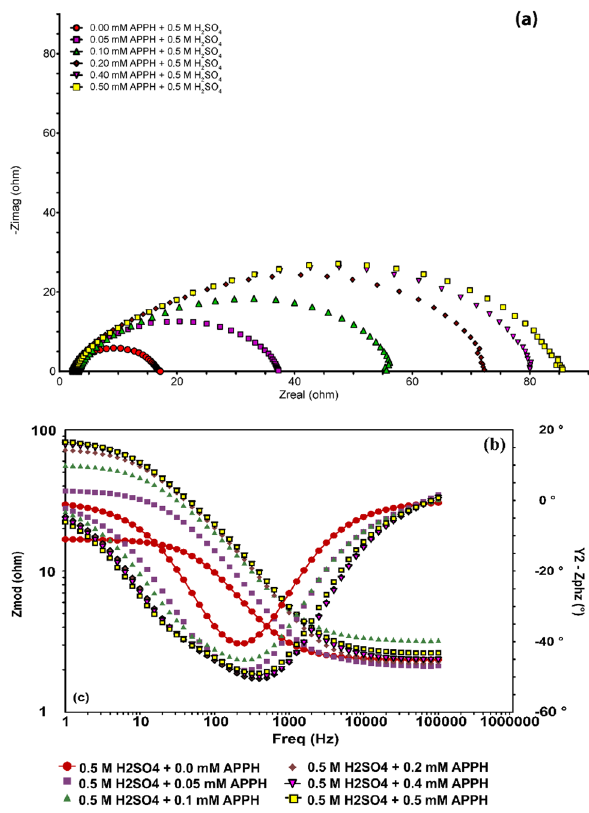
Figure 3. ( a ) Nyquist grave and ( b ) bode plots grave of LCS obtained at different APPH concentrations in 0.5 M